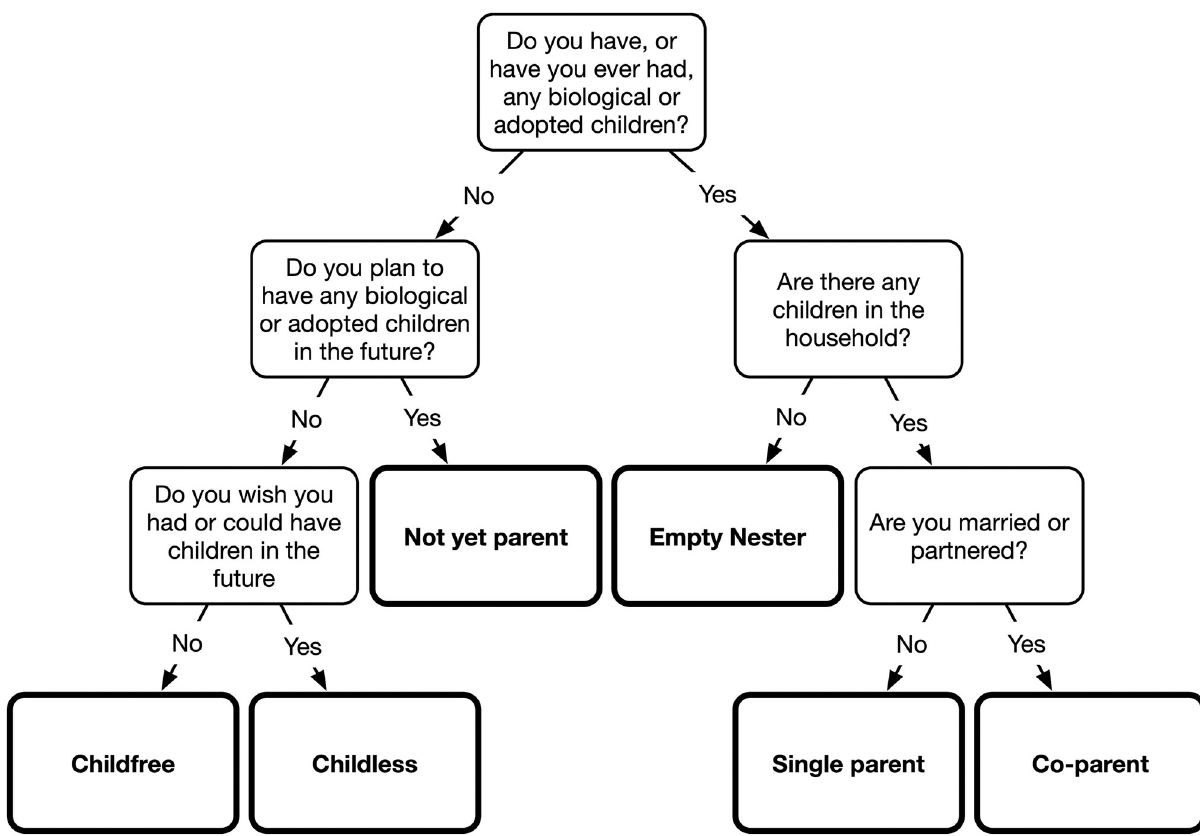
Fig 1. Decision tree for classifying respondents by reproductive